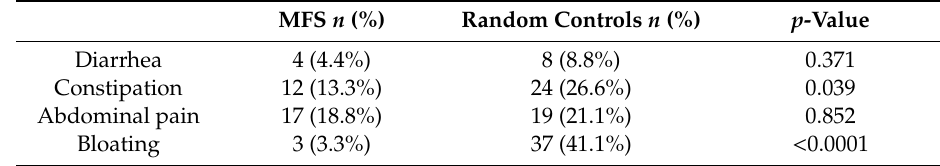
Table 1. Abdominal symptoms in patients with Marfan’s syndrome (MFS) and control